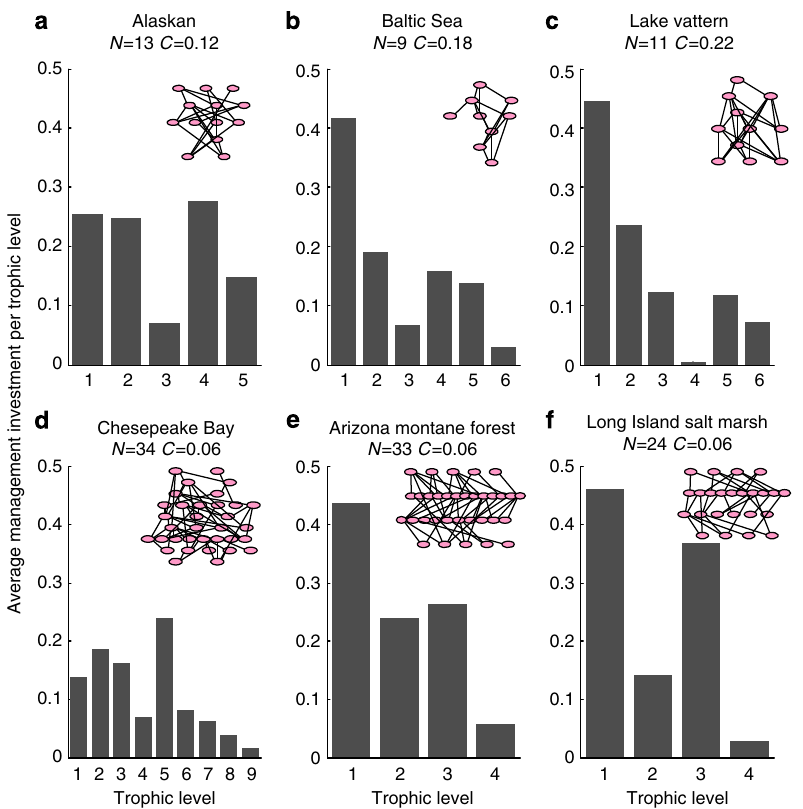
Figure 4 | Pattern of trophic level management from optimal or greedy approach for six real food webs. For a budget set at 25% of the total budget required to manage all species in the food web, the proportion managed at each trophic level from 100 simulations of species extinction risk (drawn from a Beta distribution with a ¼ 2 and b ¼ 8) and strength of interaction between species (drawn from a lognormal distribution with log-mean—3.0 and log-s.d. 1.5 ). Management reduced extinction risk of a species to zero. Alaskan ( a ), Baltic Sea ( b ), Lake Vattern ( c ), Chesapeake Bay ( d ), Arizona Montane Forest ( e ), and Long Island Salt Marsh ( f ). Inset shows the structure of the real food web and illustrates the number of trophic levels and species per trophic level, note some links have been removed from larger webs for visual